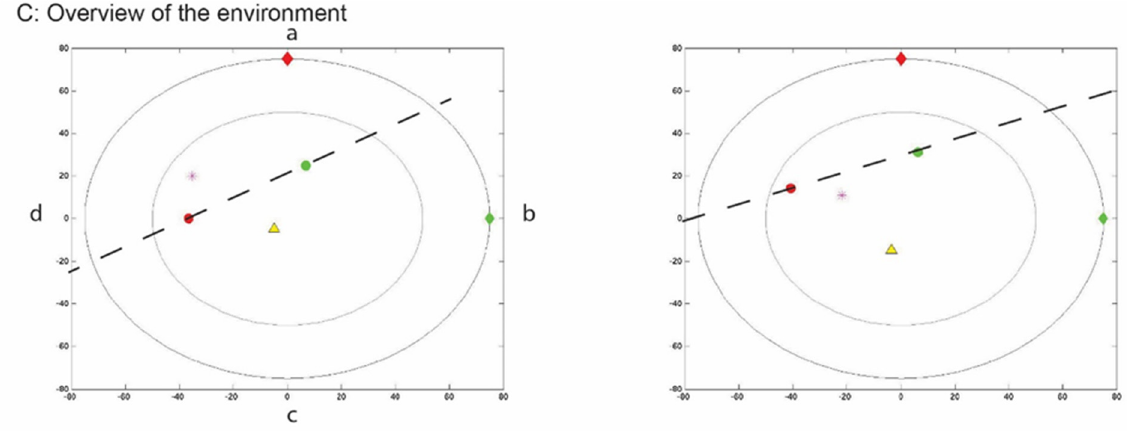
Figure 1. The navigation task: ( A ) Time course of a trial; ( B ) snapshots of the starting position for crossed cue types (combined, positional, and directional) with rotation between encoding and returning phases (0, 90, and 180 degrees); ( C ) Two trials from one participant depicted from a birds eye perspective. The red and green dots represent the columns. The yellow triangle represents the location of the ball in the encoding phase. The green diamond represents the starting location in the encoding phase, and the red diamond represents the starting location in the returning phase. The purple star represents the location where the ball was placed in the returning phase. The circular lines were not visible in the environment. Letters a – d represent possible starting locations during encoding and returning.